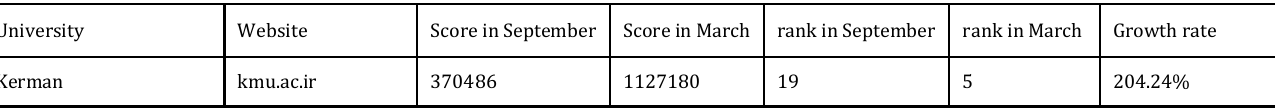
Table 1: The Webometrics rank of the website of Iranian Medical Sciences Universities in September and March (as of March) University